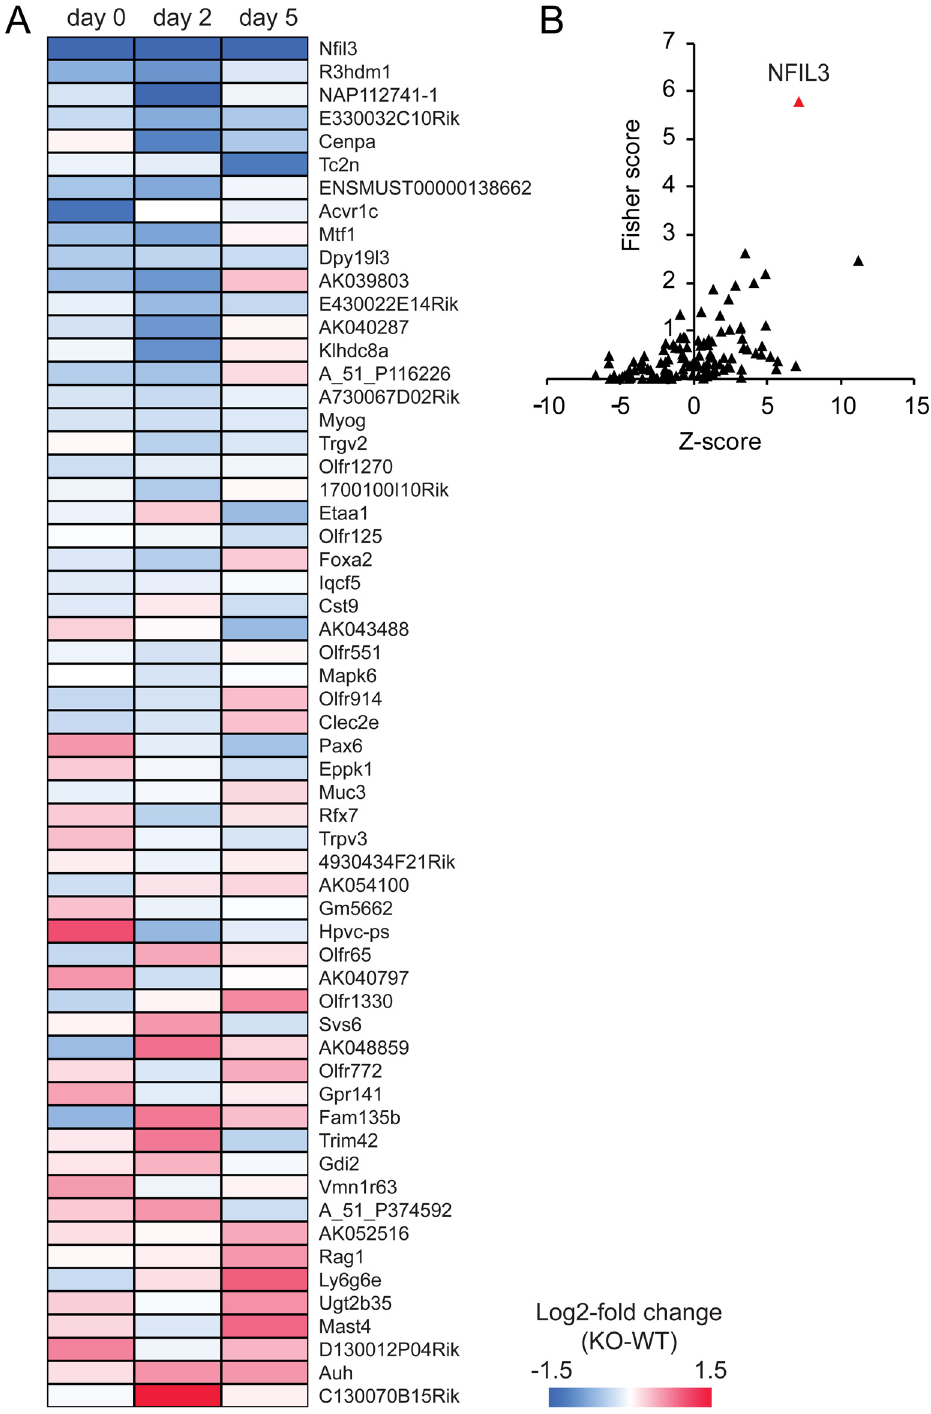
Fig 6. NFIL3 deletion alters the expression of a small set of NFIL3 target genes. (a) The injury-induced regulation of 59 genes was found significantly different in Nfil3 KO animals compared with controls. Color scale indicates log2-fold expression difference between genotypes. (b) Within the promoter regions of these 59 genes, NFIL3 binding sites are the most overrepresented binding sites judged on the combined Fisher score and Z-score computed by